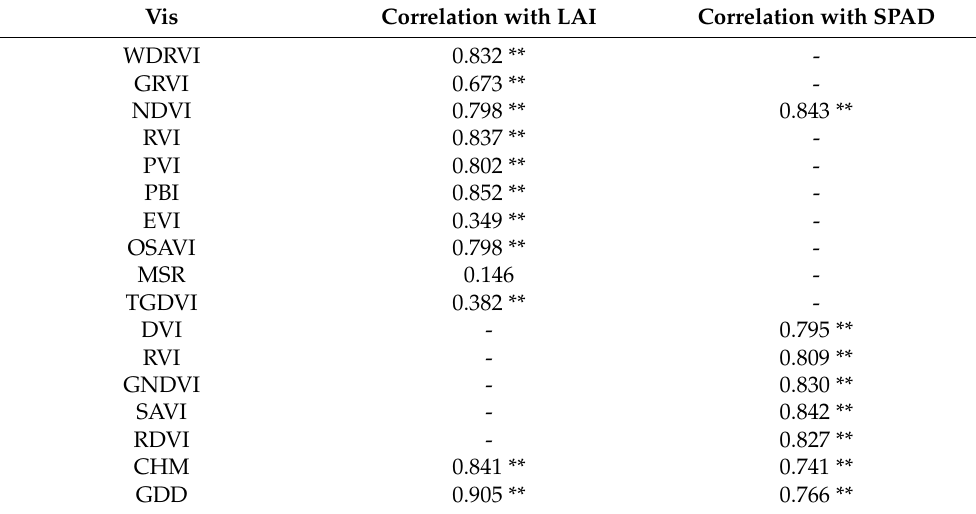
Table 4. Correlation of vegetation index and environmental characteristics with LAI and SPAD. Vis Correlation with